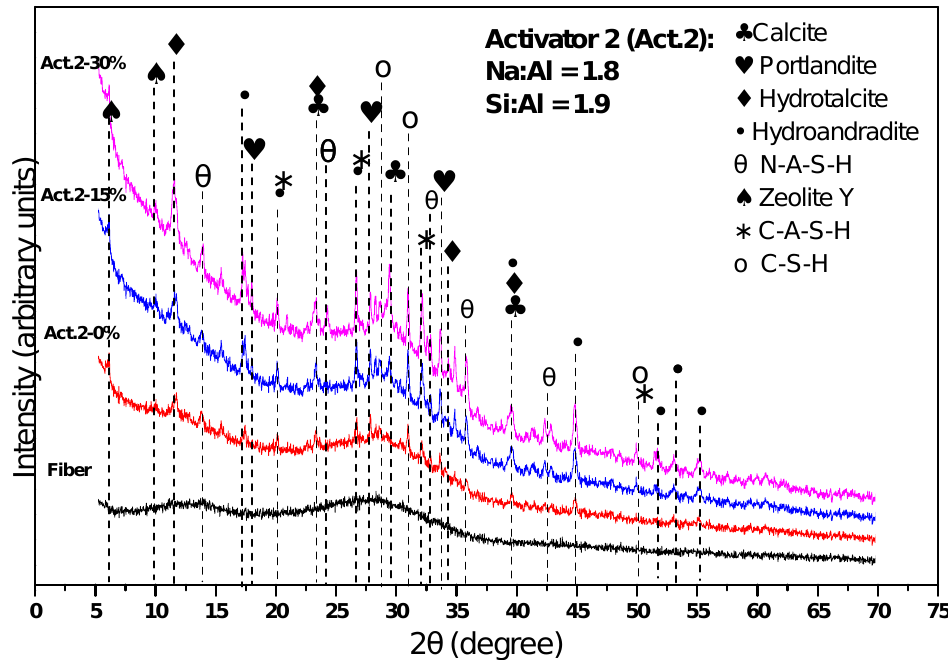
Figure 10. Diffractograms (XRD) of the combinations of alkali-activated cement with Act. 2, with- out addition and with the addition of OPC.